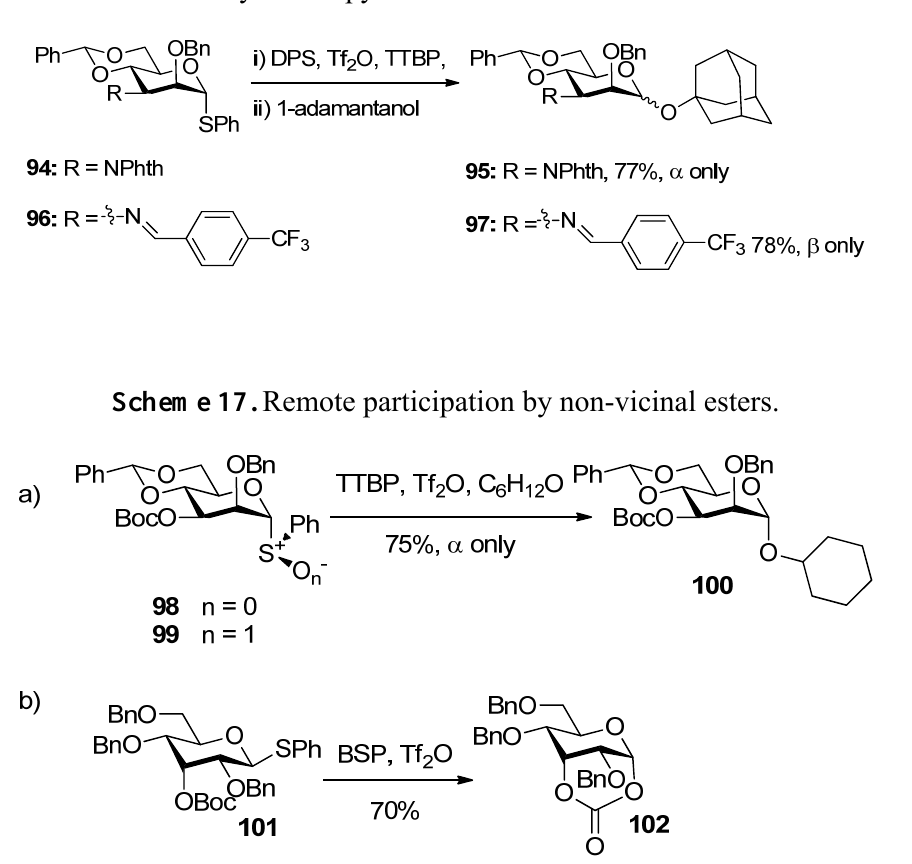
Scheme 16. Comparison of influence of different groups at C3 on stereoselectivity in the synthesis of 3-amino-3-deoxy-mannopyranosides.